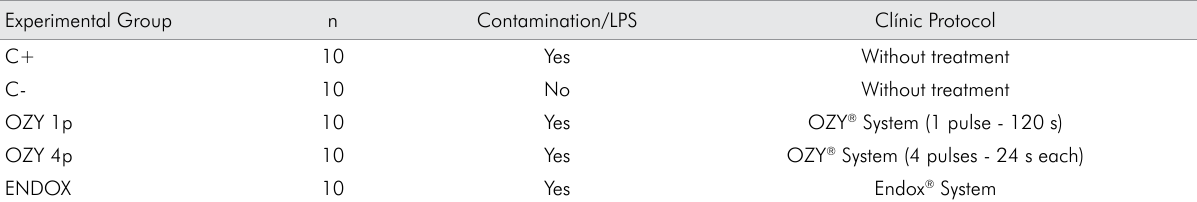
Table. Descriptive chart for the experimental groups and disinfection protocols used. Experimental Group n